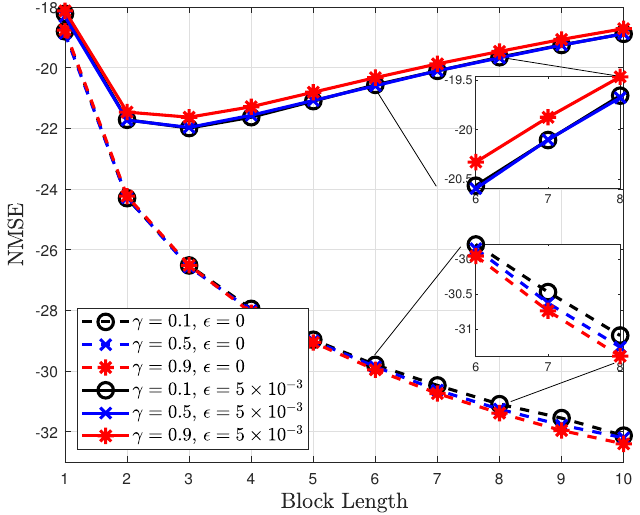
Figure 9. NMSEs of the proposed channel estimator for different discounting